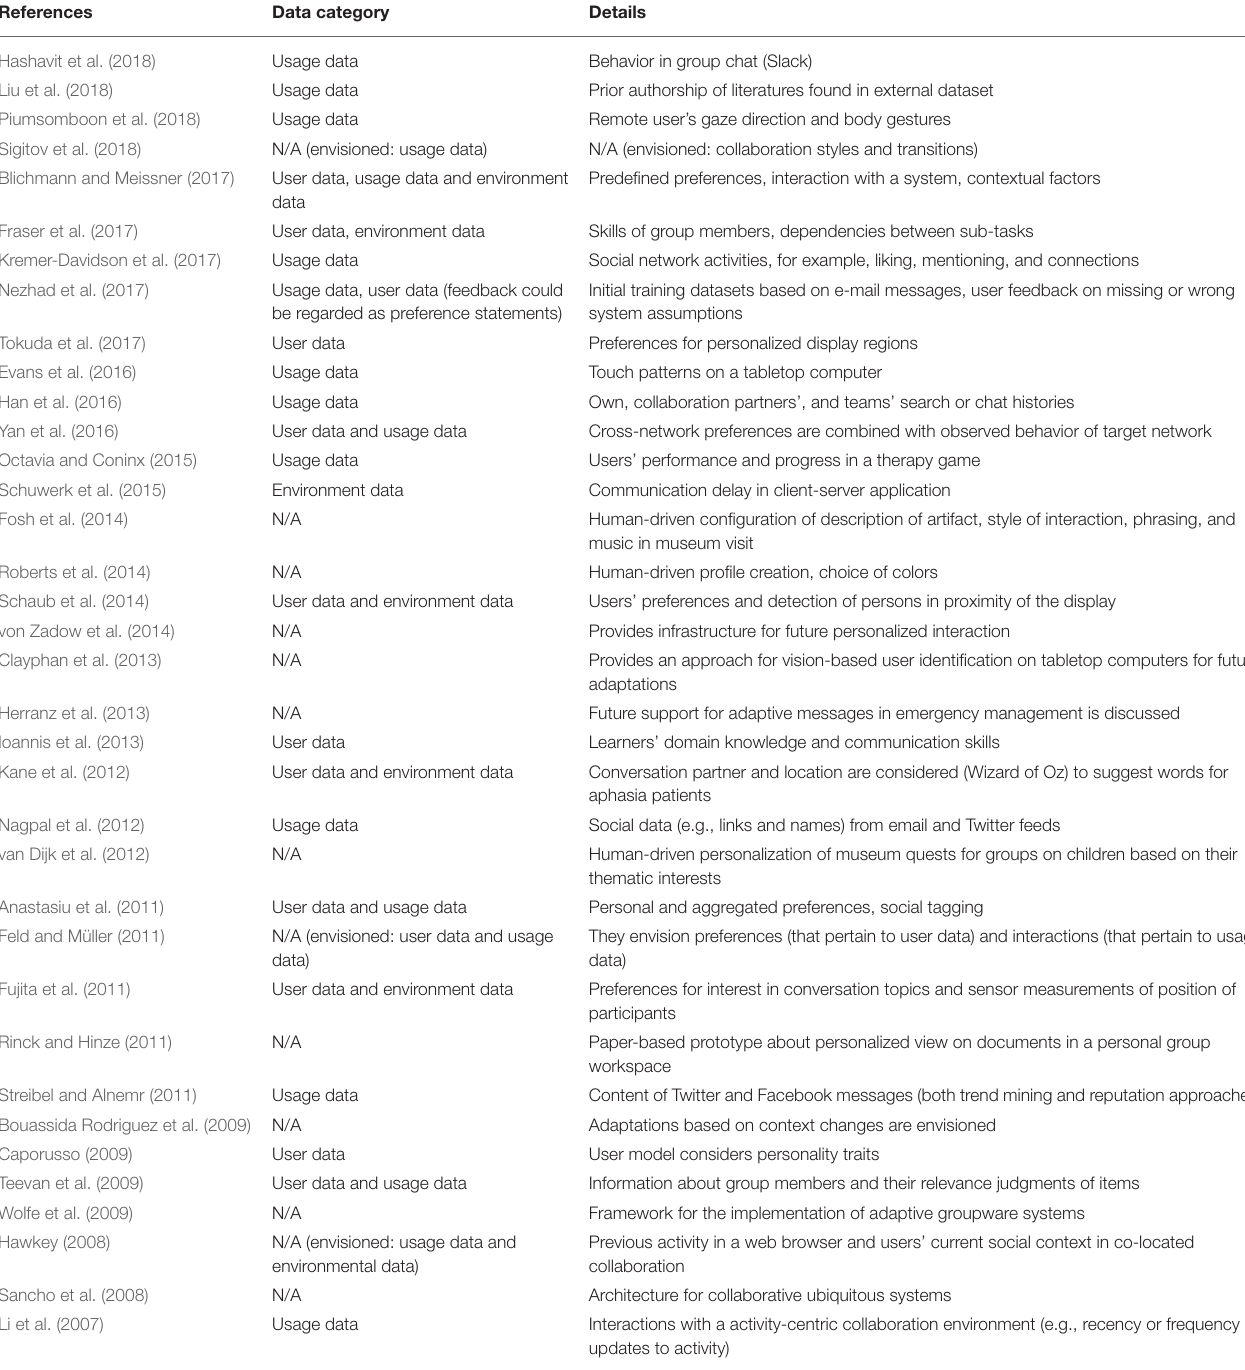
TABLE 2 | Overview of the “To What?” question, telling us what the systems adapt or personalize